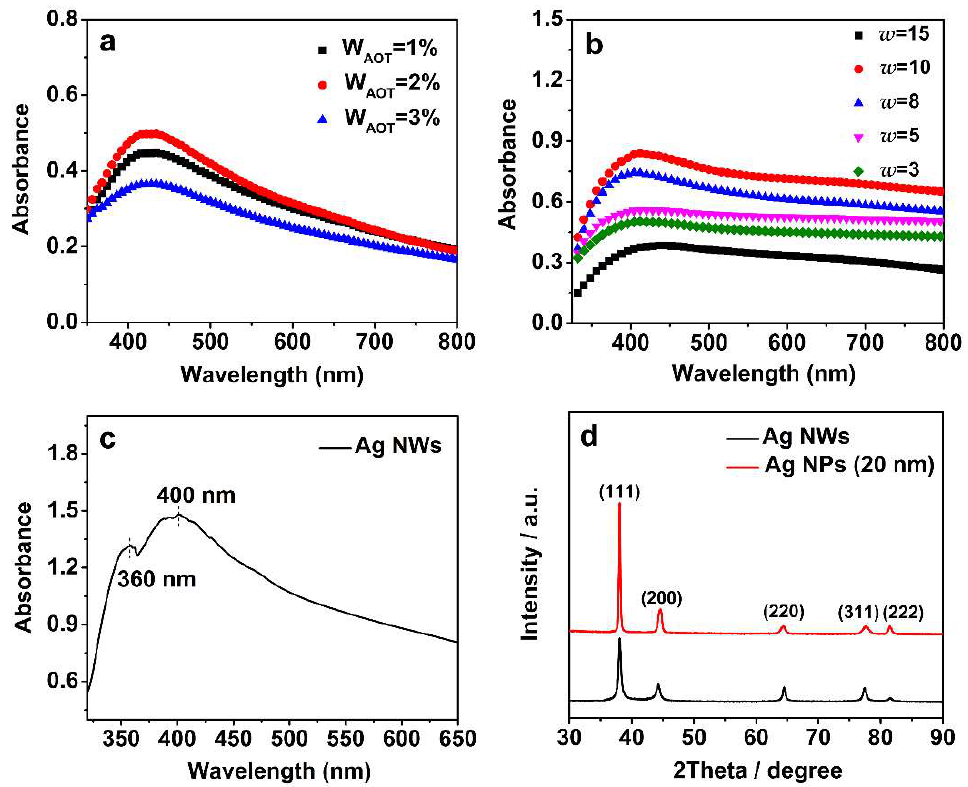
Figure 2. ( a ) Ultraviolet-visible spectroscopy (UV-vis) spectra of silver nanoparticles with different sodium bis(2-ethylhexyl) sulfosuccinate (AOT) mass fractions. UV-vis spectra of ( b ) spherical-like silver nanoparticles (Ag NP) synthesized at w = 15, 10, 8, 5, and 3 and ( c ) silver nanowires (Ag NW) synthesized at w = 25. ( d ) X-ray diffraction (XRD) of spherical-like Ag NP and Ag NW.